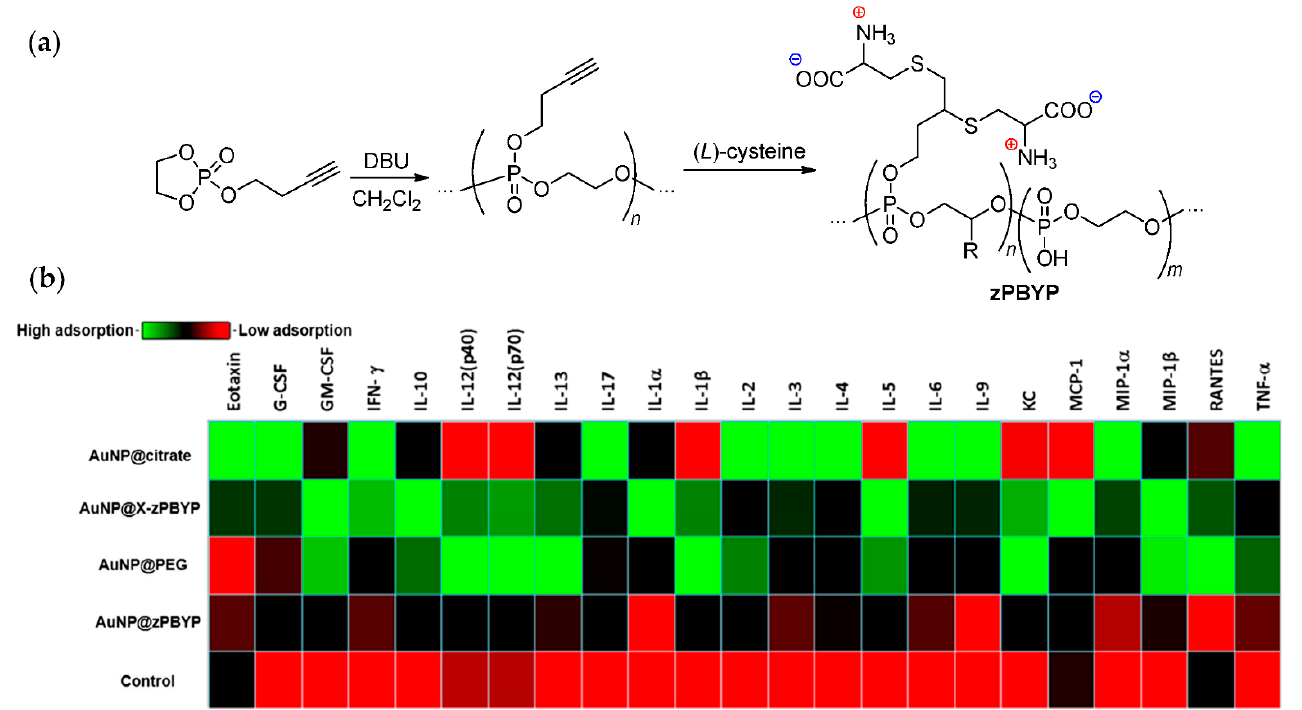
Figure 9. ( a ) Synthesis of zPBYP copolymer; ( b ) Cytokine adsorption on the coated AuNP formulations, calculated on the basis of apparent concentrations of cytokines measured after incubation with NPs and subsequent rinsing to remove unadsorbed material, as compared to the concentrations in a solution containing no NPs. The figure is the heatmap showing the concentrations of the various cytokines. Reprinted with permission from [102]. Copyright (2019) American Chemical Society.